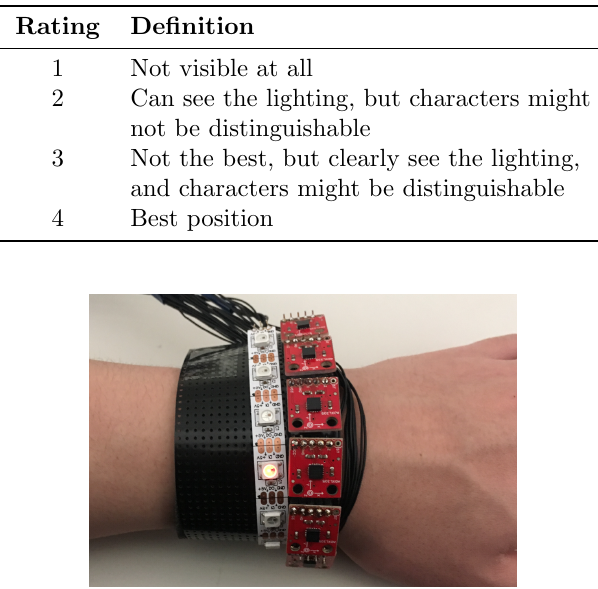
Table 2. Evaluation criteria for system-selected display position.